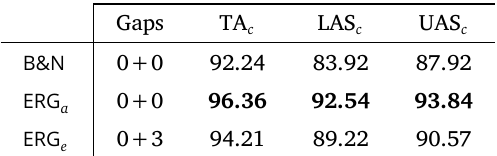
Parse failures and token mismatches (‘gaps’), and tagging and dependency accuracy on the subset of the Conan Doyle development data